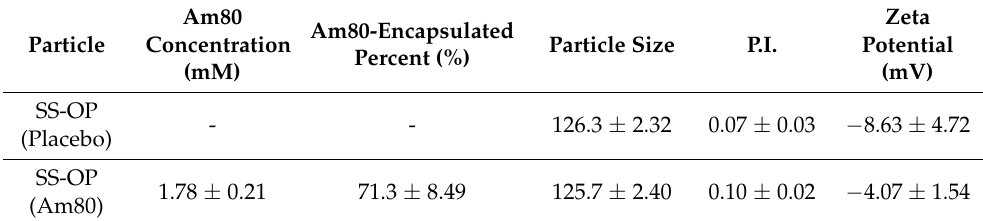
Table 1. Physicochemical properties of SS-OP nanoparticles.